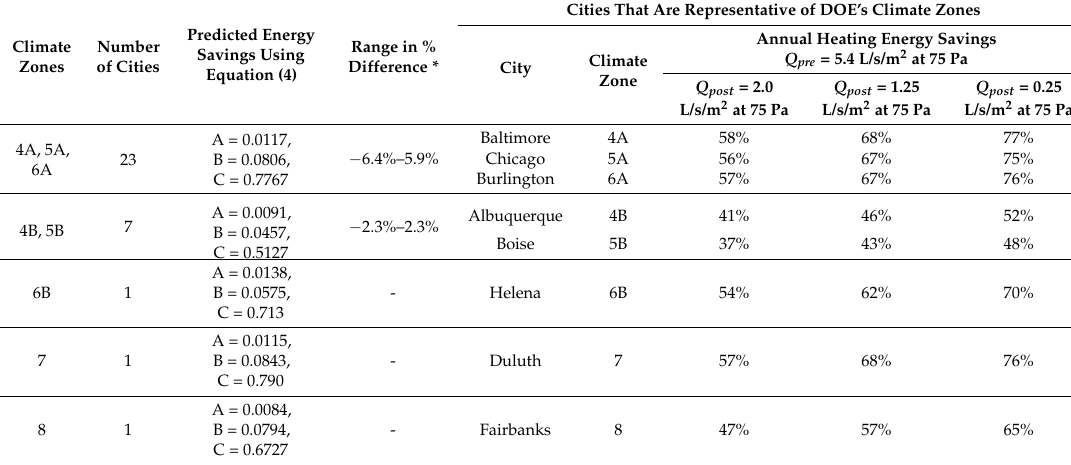
Table 4. Constants to calculate the annual relative heating energy savings using Equation (4) in climate zones 4–8, and annual relative heating energy savings results for representative cities using 5.4 L/s/m 2 as the pre-retrofit air leakage rate.